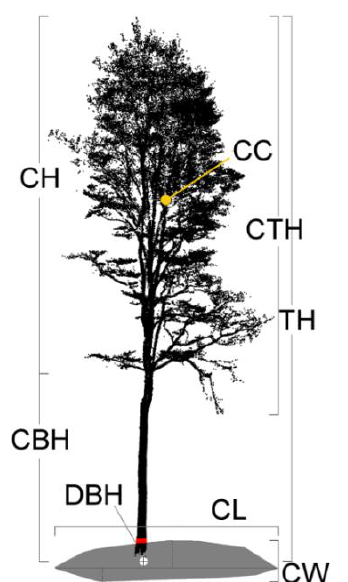
Figure 7. Extraction and visualization of tree parameters from a single tree cloud (Trochta et al. 2017): CBH–crown base height, CH–crown height, CTH–crown total height, CL–Crown length, CW–crown width, CC–crown centroid, DBH–diameter at breast height, TH–tree height, white sphere–tree position.